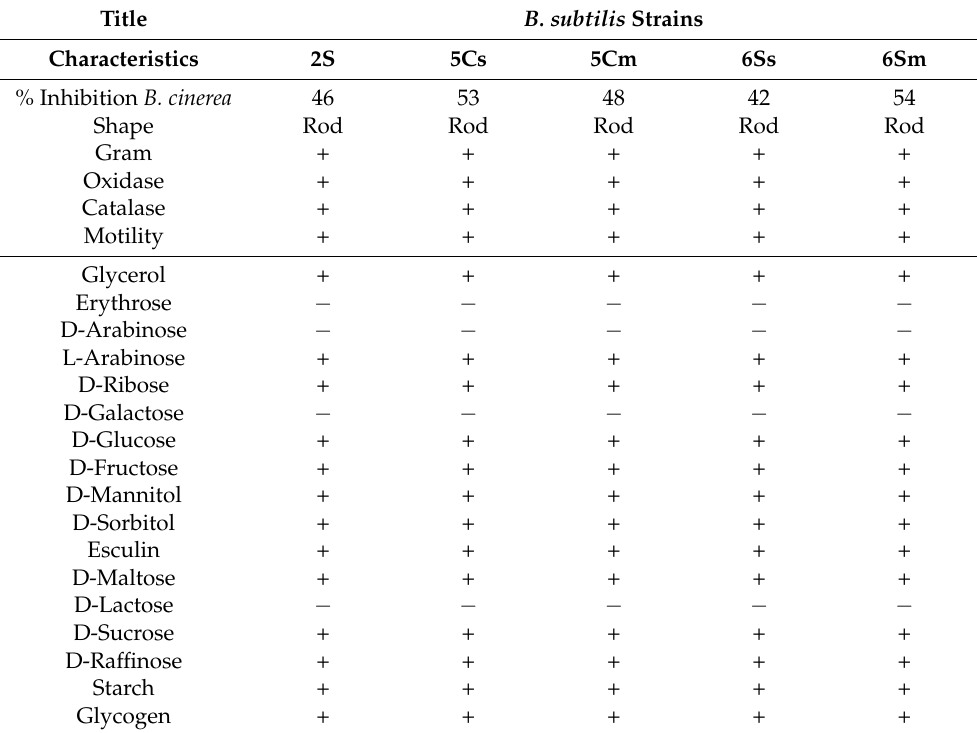
Table 3. Cell morphology and biochemical characteristics of carbon metabolisms and enzymatic activity of the five selected bacteria.